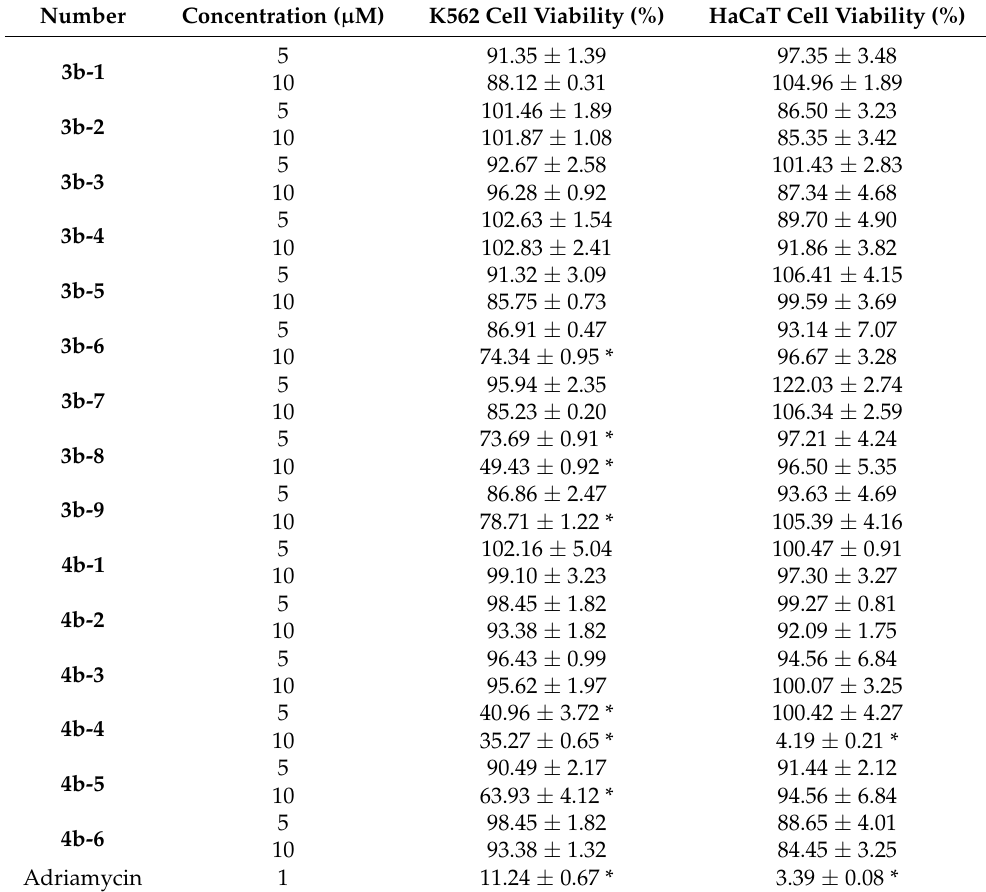
Table 1. The effect of 3b-1 to 9 and 4b-1 to 6 on the viability of K562 and HaCaT